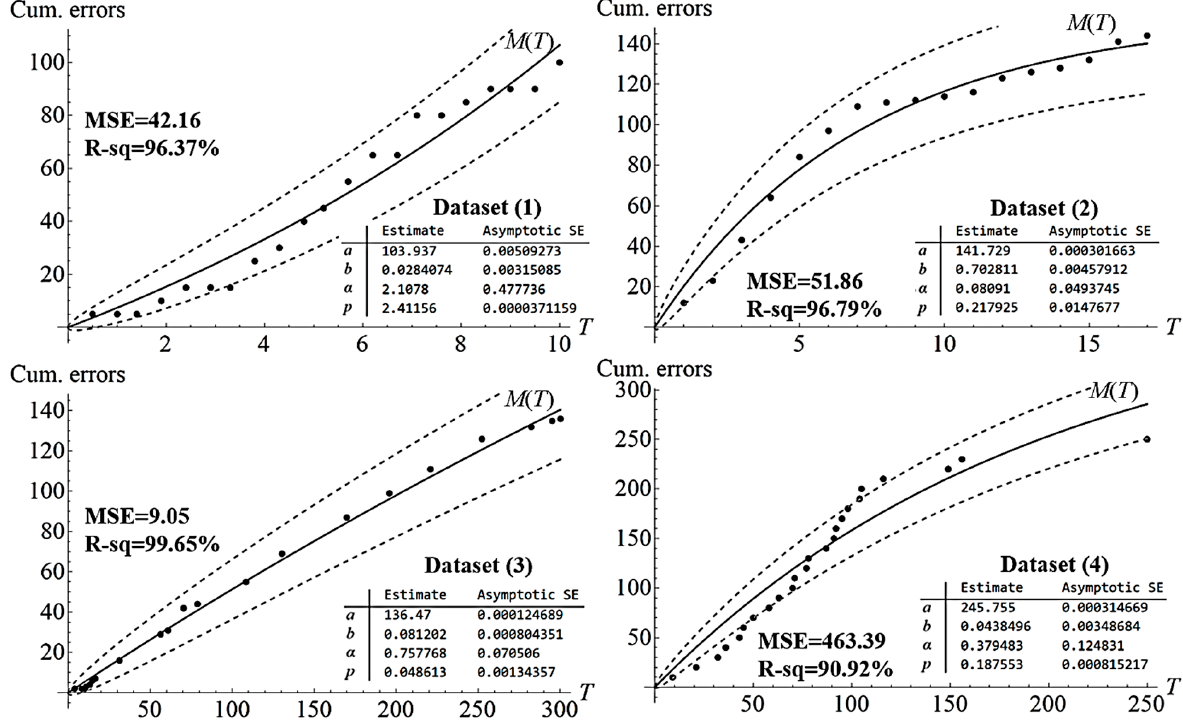
Figure 3. The fitting results and parameter estimation for Kapur’s model.